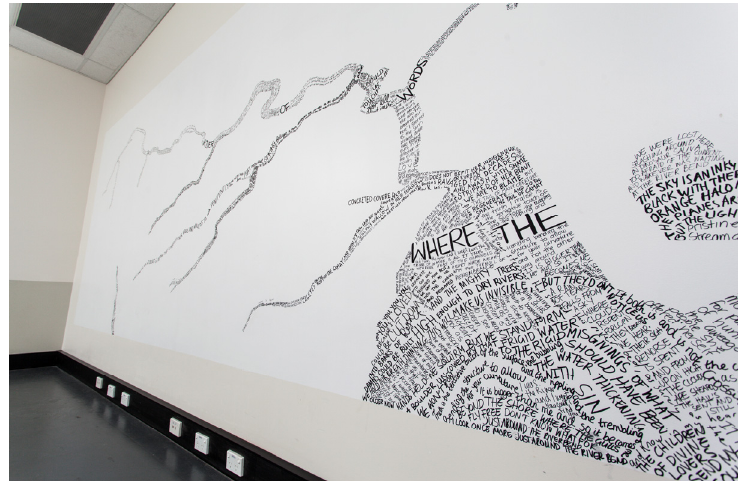
Figure 2. Installation still Where the River Rises: A River of Words. Created in collaboration with Bankstown Poetry Slam. Approx. 2.5m × 6m 2014 (Photo by Christopher Woe).